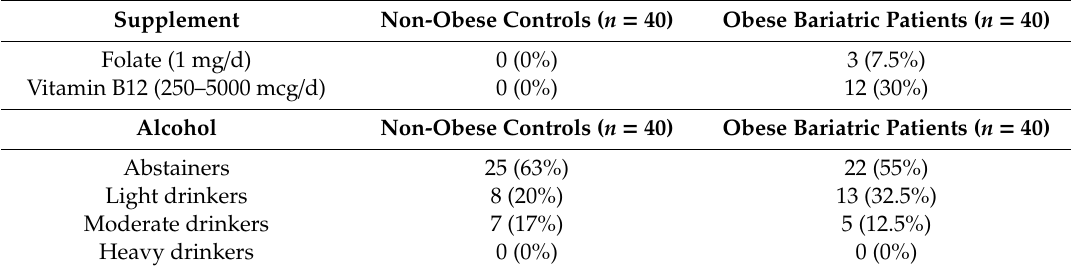
Figure 9. NO and ROS changes in response to homocysteine (Hcy) and TEMPOL. ( A ): Representative images by fluorescence microscopy of NO (red fluorescence) and ROS (green fluorescence) generation in response to Hcy and Hcy + TEMPOL treatment conditions in adipose tissue arterioles collected obese subjects ( n = 10) and non-obese controls ( n = 10). The charts present NO ( B ) and ROS ( C ) fluorescent signals that were measured and expressed in arbitrary units using NIH Image J software. All measures are represented as means ± SE. * ( p < 0.05) for comparing L-NAME to baseline in each group, and † ( p < 0.05) for comparing obese subjects with controls. Table 4. Consumption of alcohol and vitamin B12 and folate